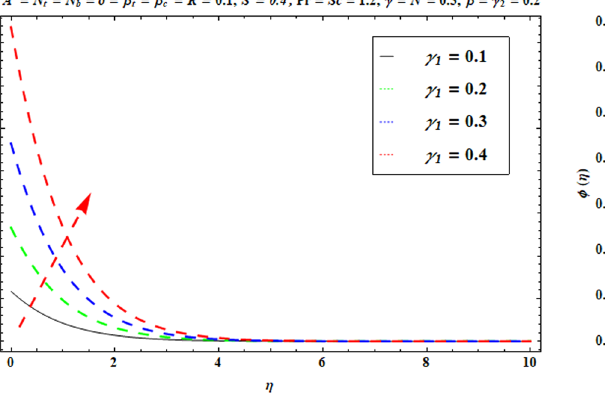
Figure 17: ϕ η ( ) versus γ .